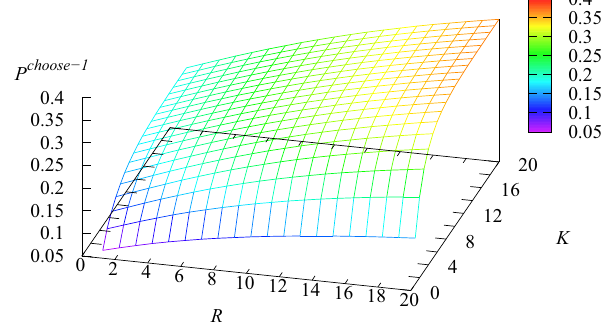
Figure 14. Dependence of the probability P choose − 1 that an arbitrary Type-1 request will be selected for service from the first buffer without visiting the main buffer on K and R .